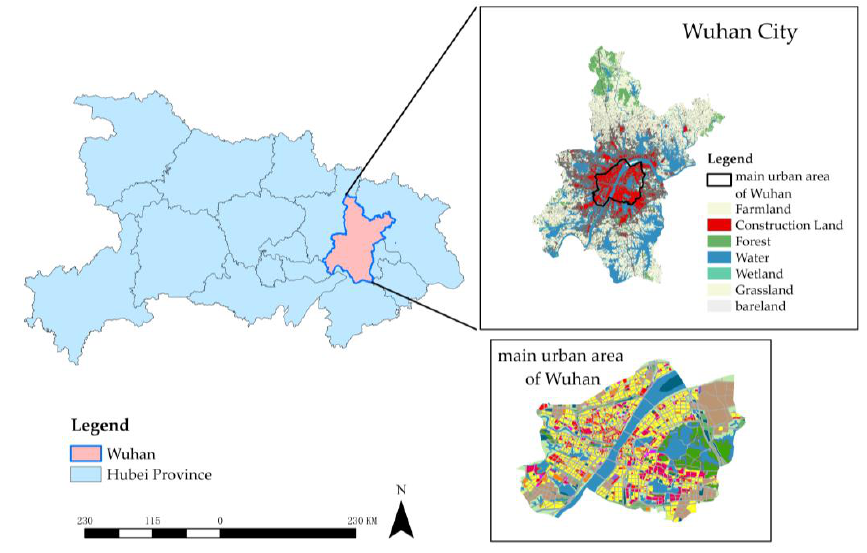
Figure 1. Map of the main urban area in Wuhan.